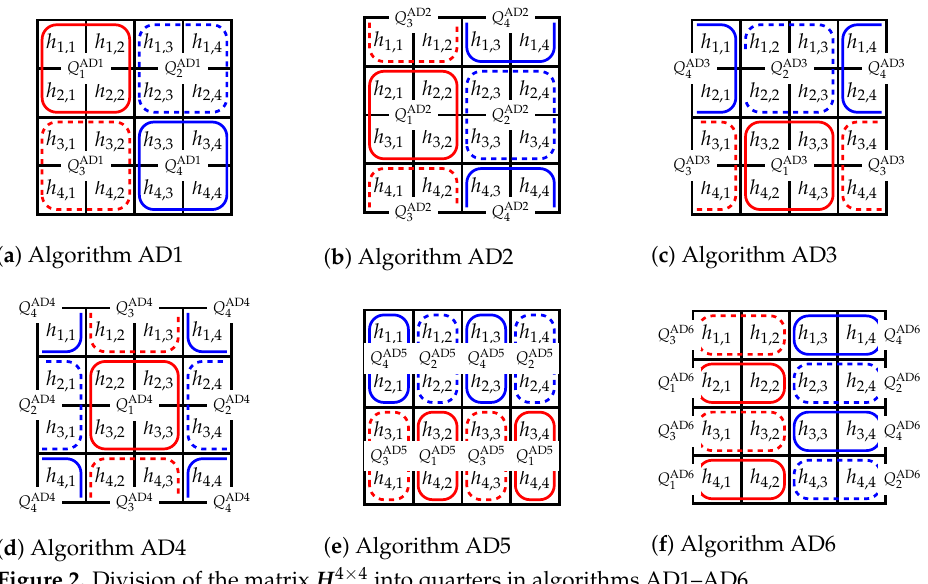
Figure 2. Division of the matrix H 4 × 4 into quarters in algorithms AD1–AD6. The divisions of H 4 × 4 elements into subregions for algorithms AD1, AD2, and